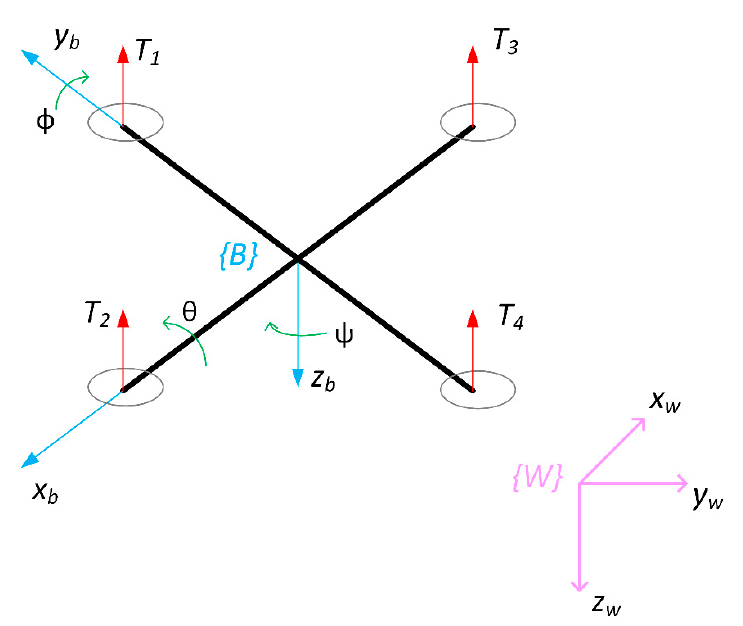
Figure 12. World and body frames of quadrotor UAV.